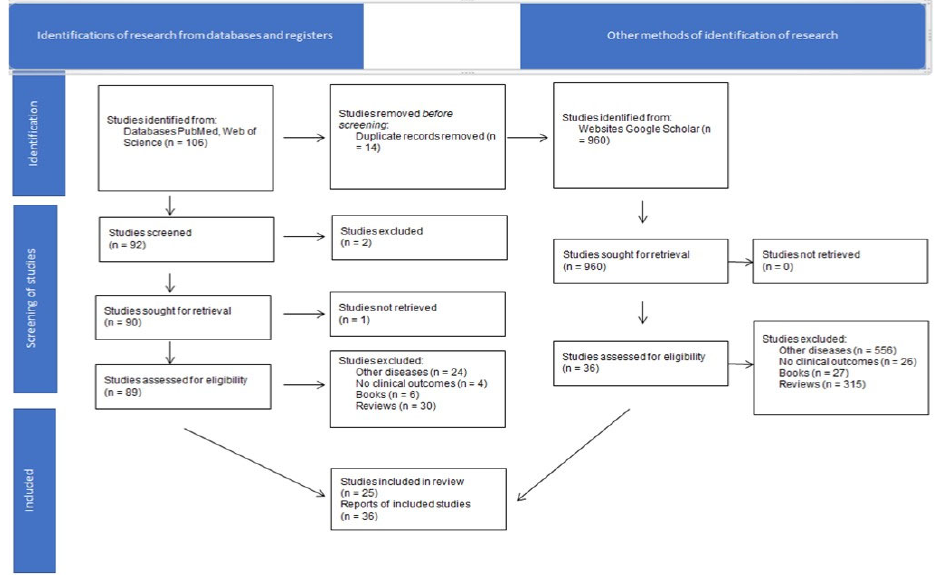
Figure 1. Research flowchart for identification of related articles.